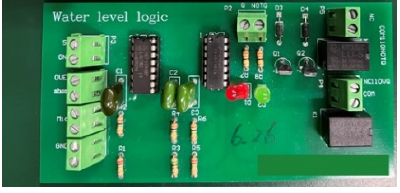
Figure 10. The module of the water overflow sensor.